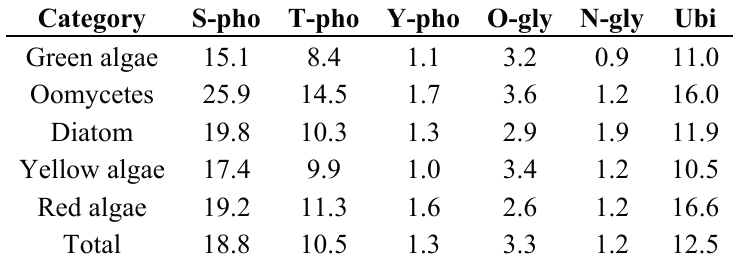
Table 2. Relative post-translational modification (PTM) content in ordered and disordered regions of algae